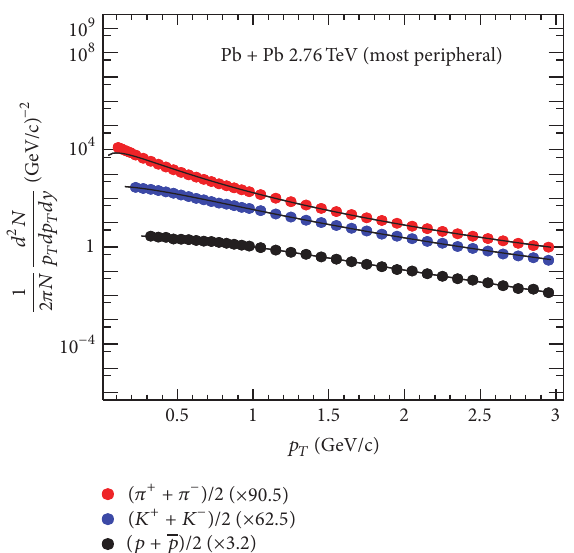
Figure 12: Fitting of invariant 𝑝 𝑇 spectra with Tsallis distribution using (7) for (𝜋 + +𝜋 − )/2 [19, 20], (𝐾 + +𝐾 − )/2 [19, 20], and (𝑝+𝑝)/2 [19, 20] in most peripheral Pb + Pb collisions at √𝑠 NN = 2.76 TeV. Symbols represent the data points and line is the fit function.